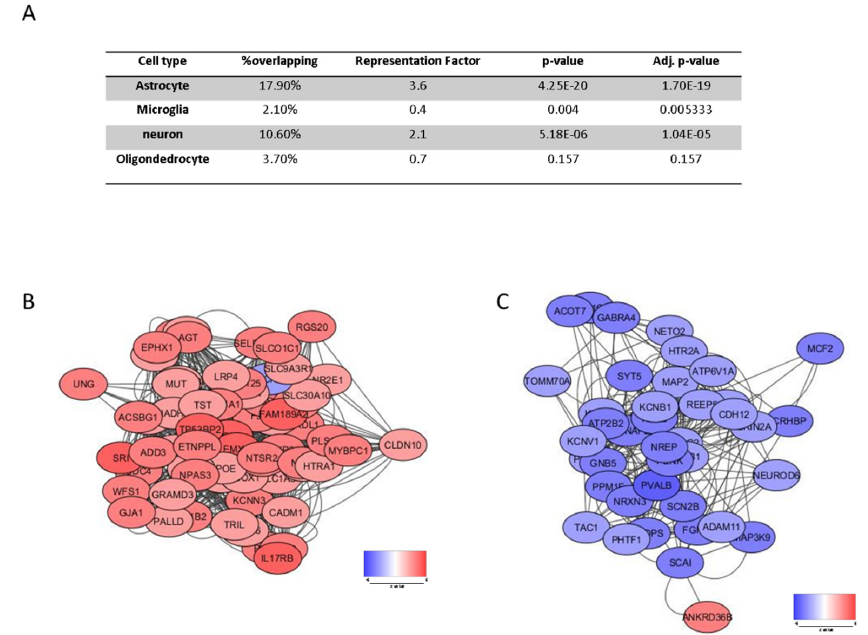
Figure 5. ( A ) Enrichment of brain cell type specific genes among the differentially expressed genes (DEGs) obtained from the meta-analysis of the GSE53987, GSE12649 and GSE21138 datasets; ( B ) network of the astrocyte-specific DEGs obtained from the meta-analysis of the GSE53987, GSE12649 and GSE21138 datasets. The network is color coded by the z value; ( C ) network of the neuron-specific DEGs obtained from the meta-analysis of the GSE53987, GSE12649 and GSE21138 datasets. The network is color coded by the z value. “% overlapping” indicates the percentage of SCZ genes shared with the cell-type specific gene signature; the “representation factor” is the number of overlapping genes divided by the expected number of overlapping genes from the compared groups. A representation factor > 1 indicates more overlap than that expected of two groups, a representation factor < 1 indicates less overlap than expected. Table 1. Top 10 enriched terms among the astrocyte-specific DEGs.